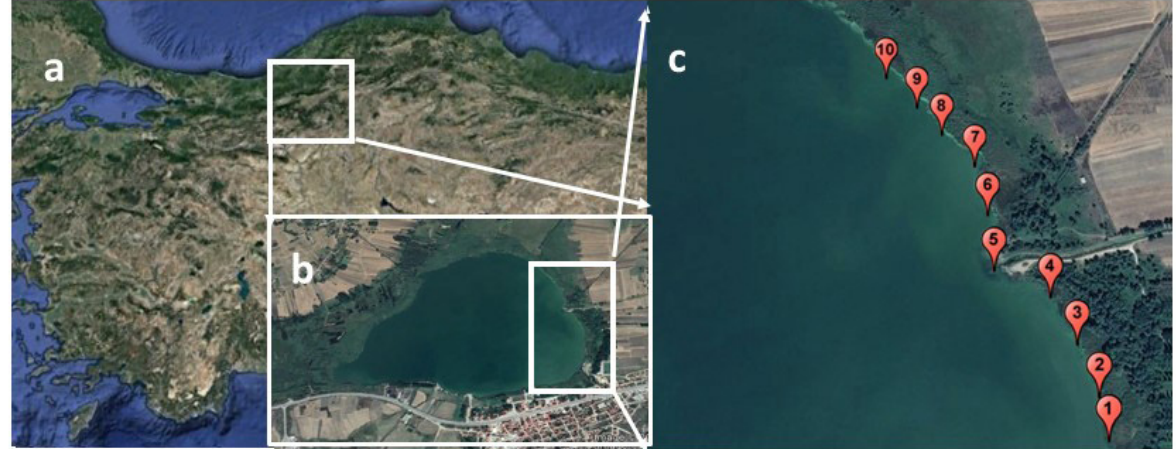
Figure 1. The map showing the sampling locations. (a) Turkey, (b) Yeniçağa Lake, (c) Deliler